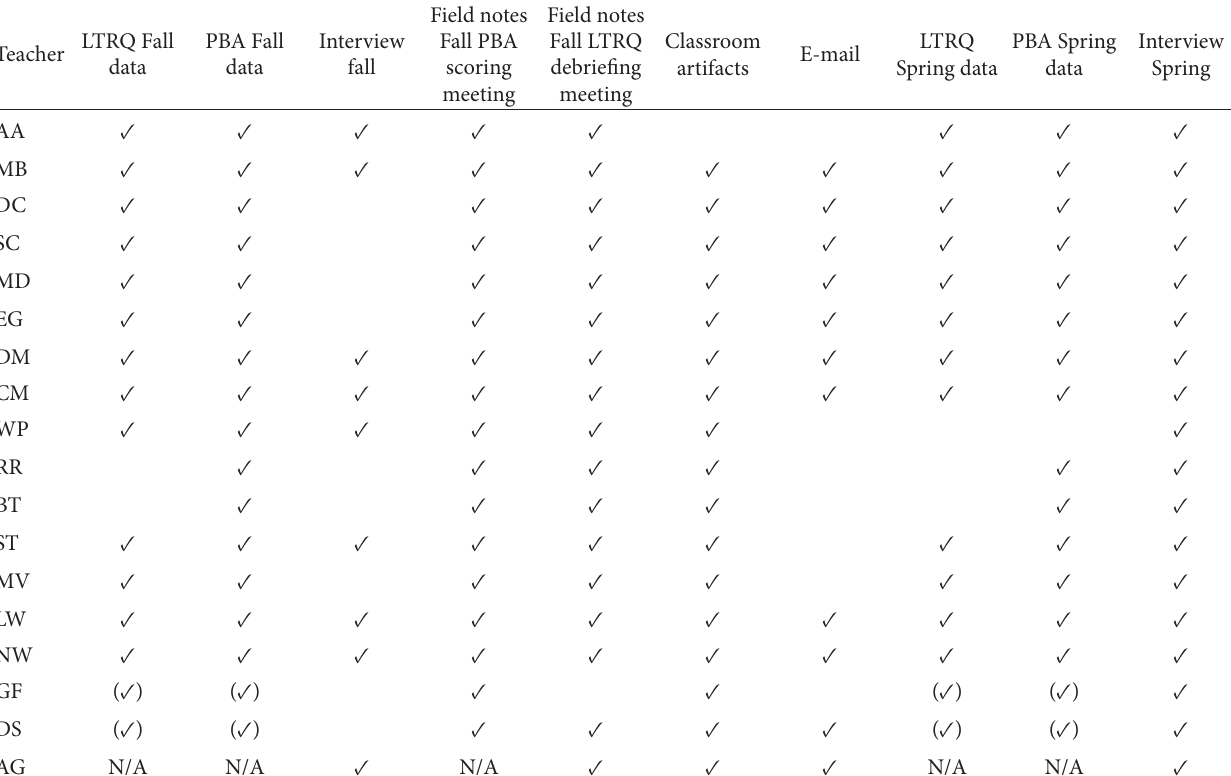
T 2: Data sources available for each